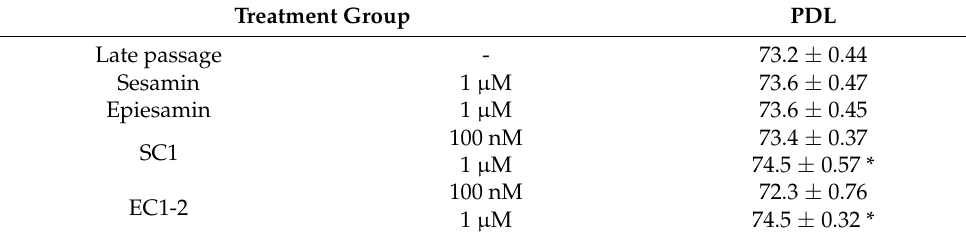
Table 1. Effects of sesamin, episesamin, and their metabolites on proliferative